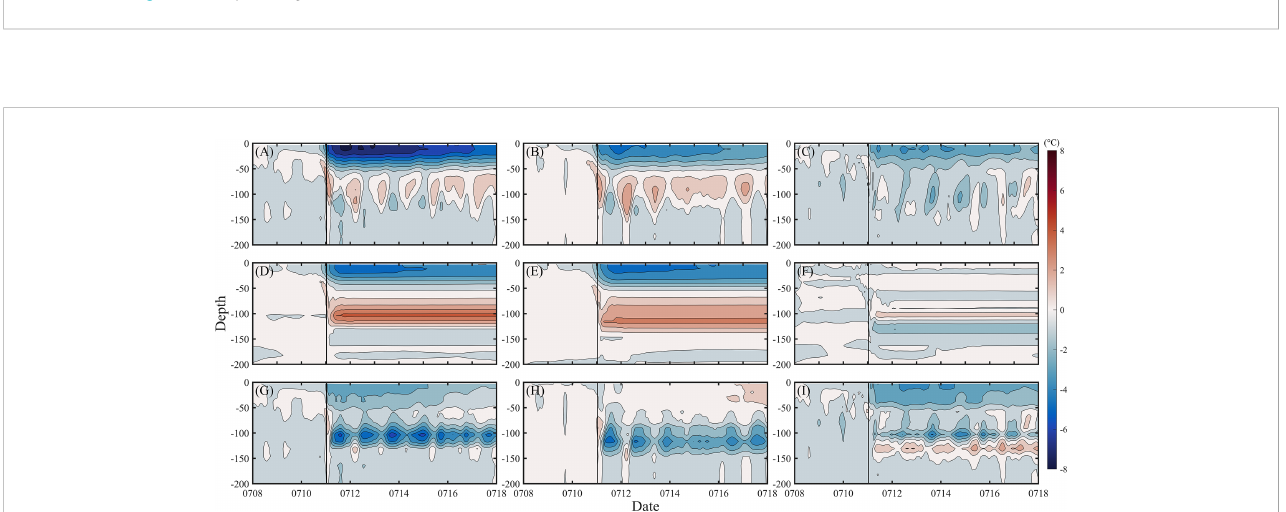
FIGURE 9 Modeled upper ocean temperature anomaly at M2 in (A) EXP HYCOM , (B) EXP CLIMAT , and (C) their difference; accumulated contribution of vertical mixing to the temperature anomaly in (D) EXP HYCOM , (E) EXP CLIMAT and (F) their difference; accumulated contribution of advection to the temperature anomaly in (H) EXP (I) their difference. The differences are obtained by subtracting the EXP (G) EXP HYCOM , CLIMAT and